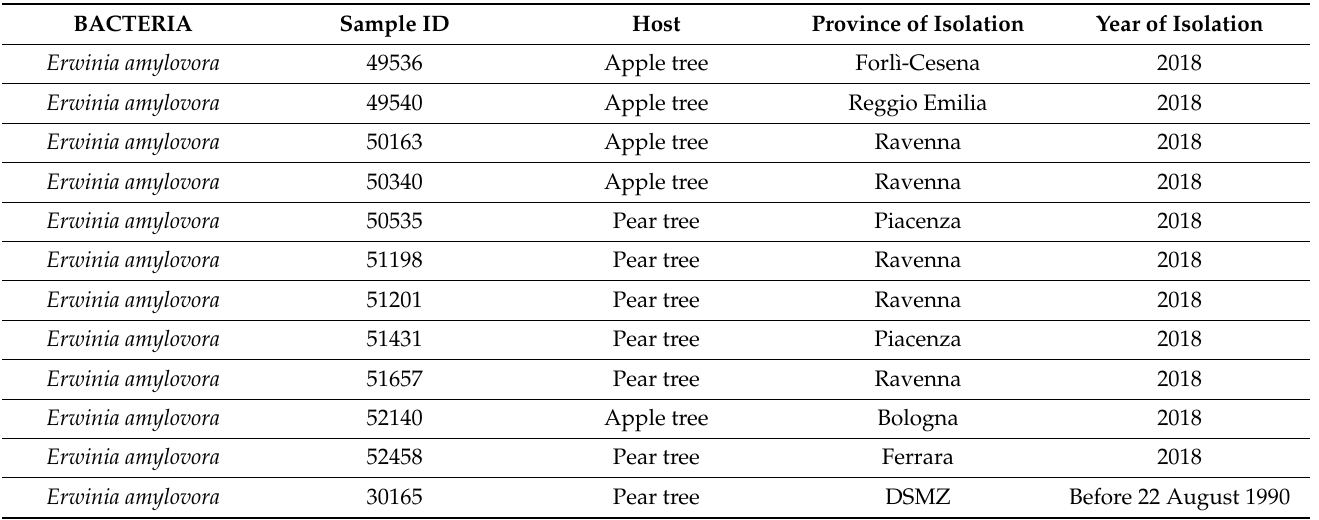
Table 2. List of EA bacterial